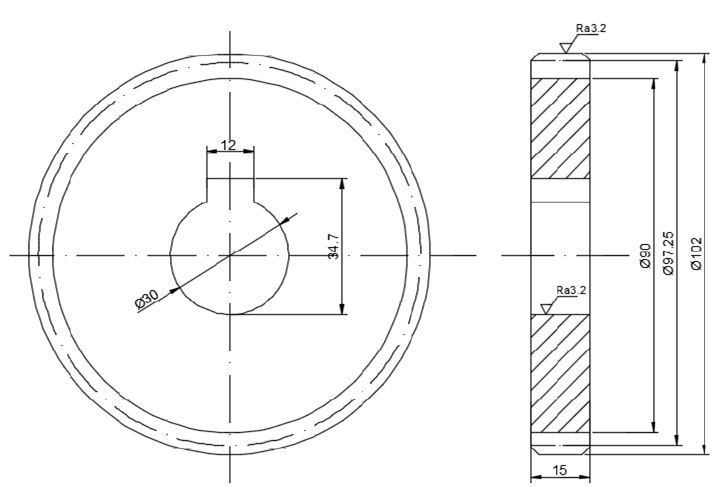
Figure 7. Gear dimension drawing. Table 1. Gear parameters.